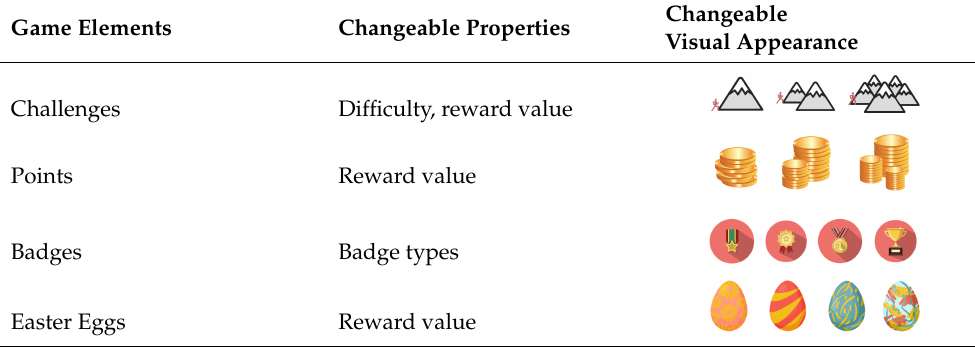
Table 1. Details of the Game Element Properties and Appearances changeable as a function of the global score values. These game elements will change their properties and their appearance depending on the global